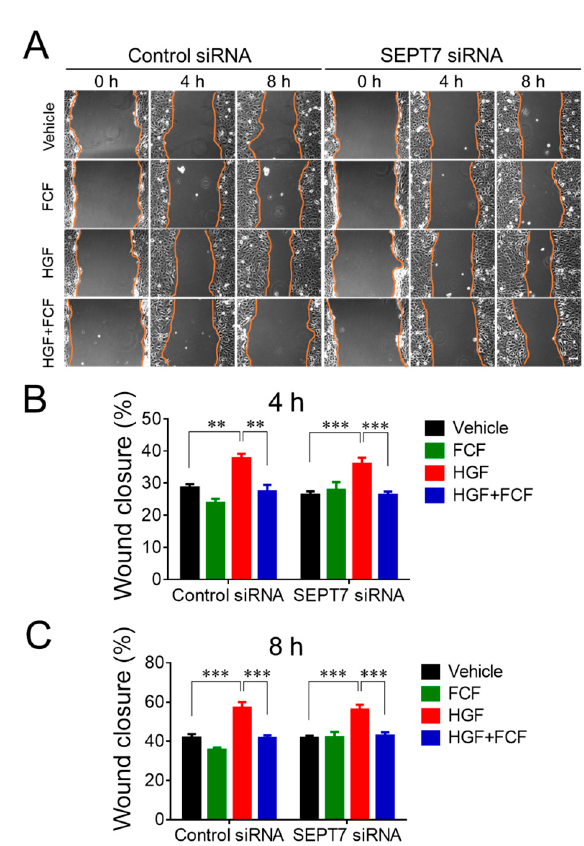
Figure 5. Forchlorfenuron inhibits hepatocyte growth factor-induced migration of control and septin-depleted prostate epithelial cells. Control and SEPT7-depleted DU145 cells were subjected to either spontaneous or HGF-induced wound healing assay with, and without, FCF, as described in the Figure 2 legend. ( A ) Representative images of wounded DU145 cell monolayers. ( B , C ) Quantitation of wound closure during 4 and 8 h of cell migration. Data are presented as a mean ± SE (n = 5); ** p < 0.01, *** p < 0.001. Scale bar, 100 µm.